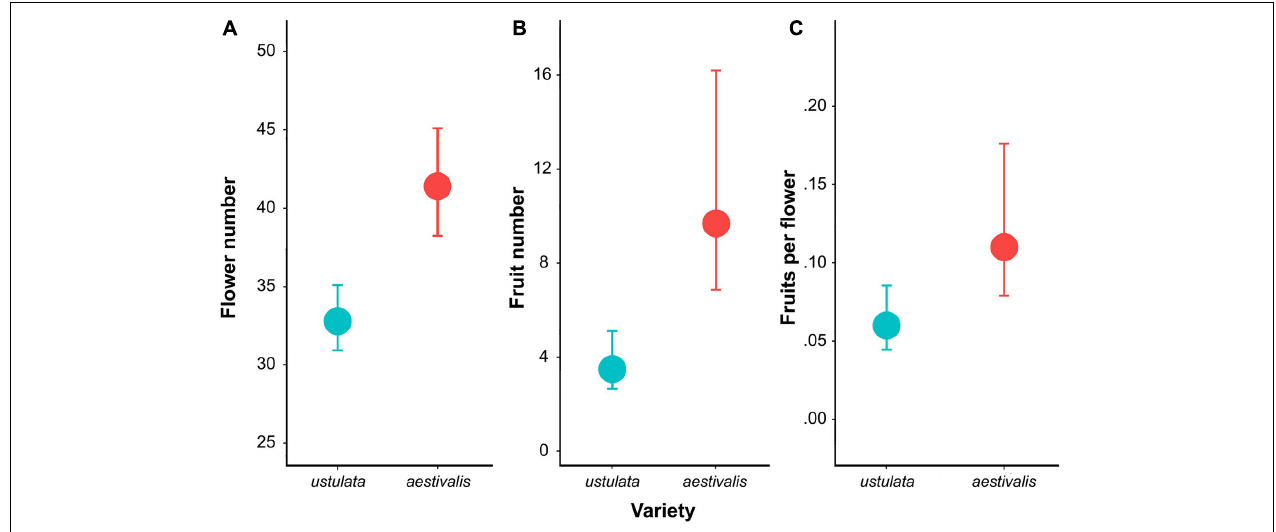
FIGURE 6 | Floral traits related to reproductive success: (A) the number of flowers, (B) the number of fruits, and (C) proportion of flowers that set fruit between Neotinea ustulata var. ustulata and var. aestivalis . Back-transformed means and standard errors are shown.